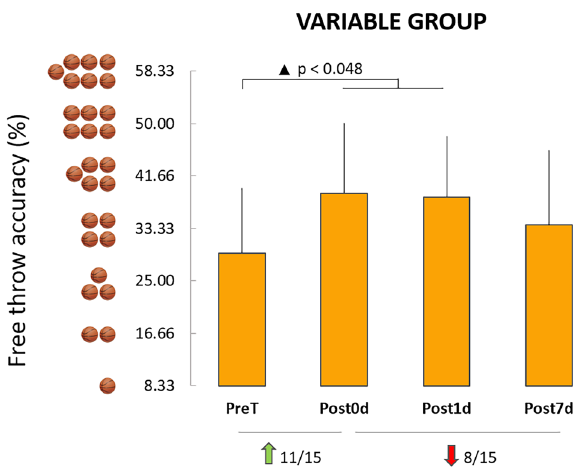
Figure 4. Average values (+ SD) of the free throw accuracy (%) for the variable group and the four tests. Black triangles indicate significant improvement between sessions. Green arrows, Red arrows indicate the number of participants who improved or decreased their free throw accuracy, respectively. The basketballs near the vertical axis indicate the number of successful free